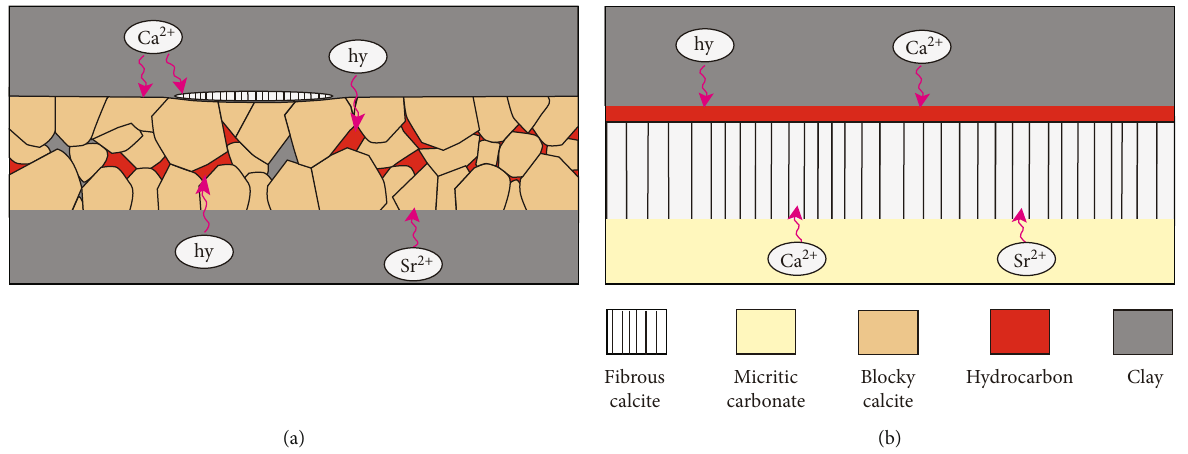
Figure 15: Pattern of hydrocarbon accumulation of blocky and fi brous veins (hy: